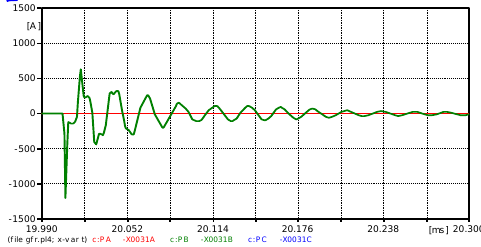
Fig. 16. The transformer zoomed primary current.